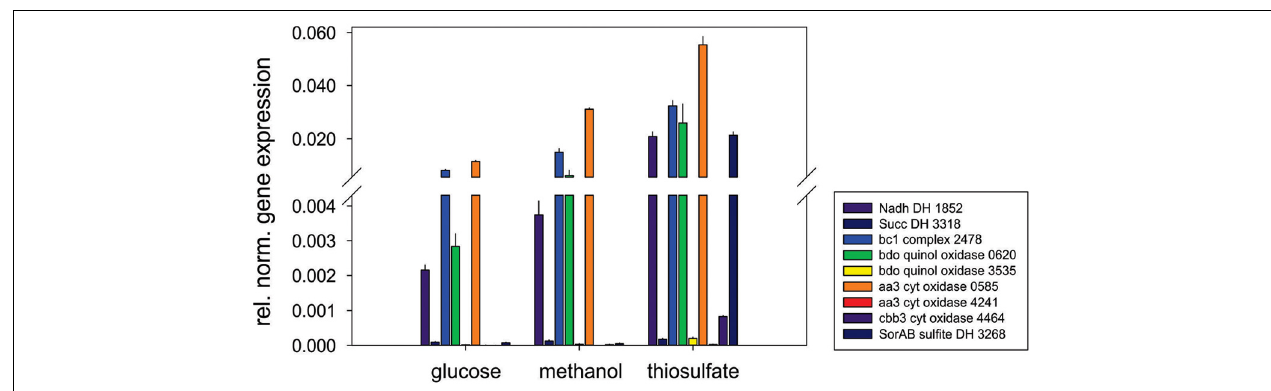
FIGURE 3 | Expression of respiratory chain genes in S. novella cultures grown under hetero-trophic, methylotrophic, or sulfur chemolithoautotrophic conditions. Error bars represent the Standard Deviation of the mean, gene expression was normalized relative to the expression of the 16S RNA